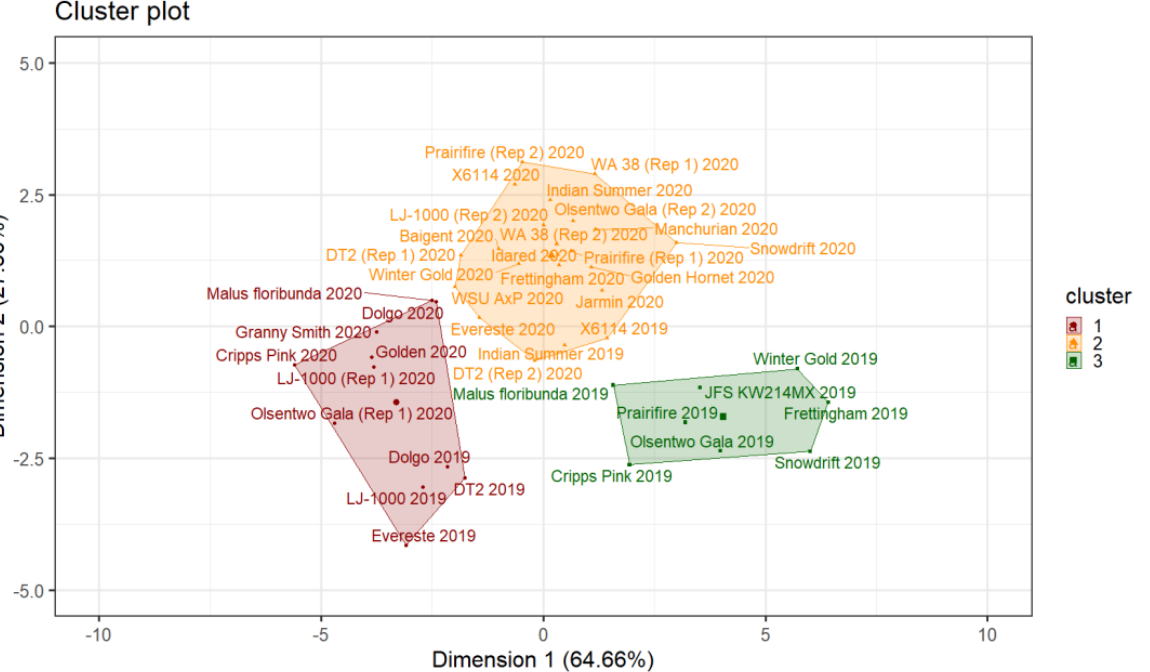
Table 1. Statistical characterization of clusters identified by hierarchical clustering on principal components.